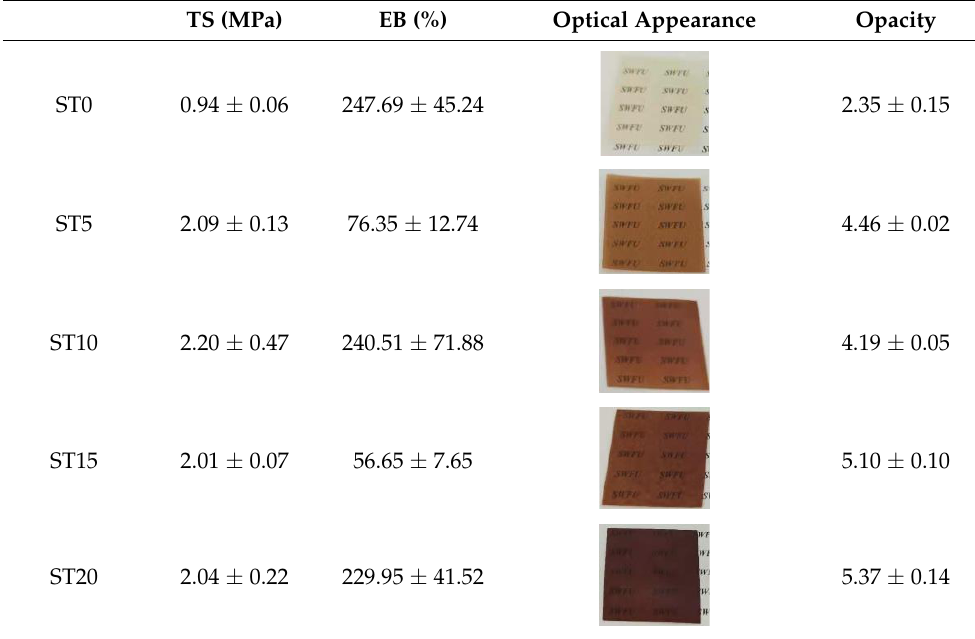
Table 1. Mechanical properties, optical appearance and opacity of SPI – BT films.